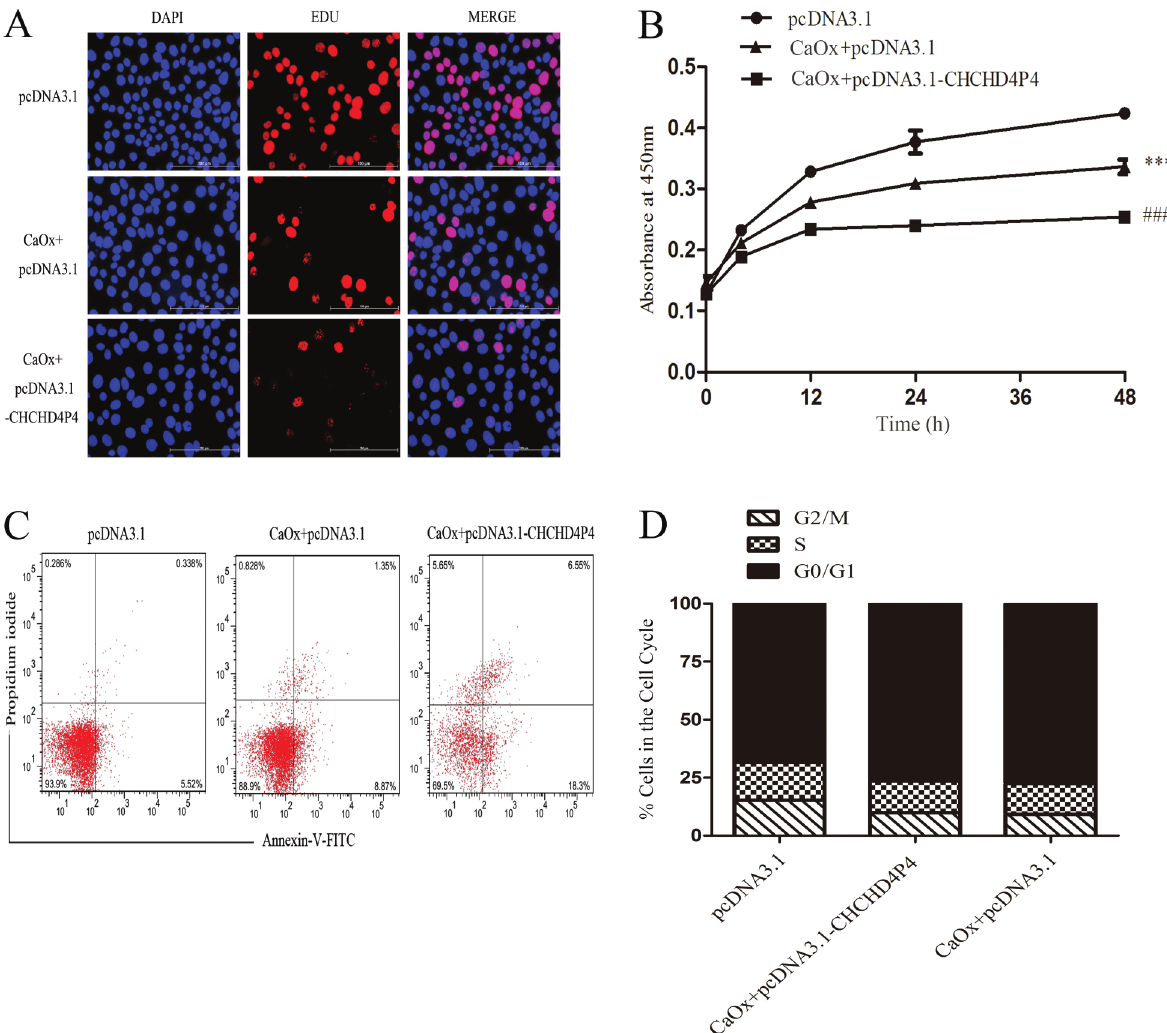
Figure 6. Effect of CHCHD4P4 on the cell cycle of HK-2 cells. Immuno fl uorescence microscopic analysis of 5-ethynyl-2 ’ -deoxyuridine (EDU) ( A ) in the indicated HK-2 cell clones. Scale bars = 100 m m. Blue represents the nucleus, and red indicates the proliferation of cells. The CCK8 assay ( B ) was used to assess HK-2 cell proliferation (***P o 0.001 vs pcDNA3.1, ### P o 0.001 vs CaOx + pcDNA3.1, t -test). Annexin V fl ow-cytometric analysis of the HK-2 cells that were transfected with the pcDNA3.1 encoding CHCHD4P4 cDNA for 6 h and treated with calcium oxalate monohydrate for 24 h ( C ). Cell cycle analysis of the HK-2 cell clones ( D